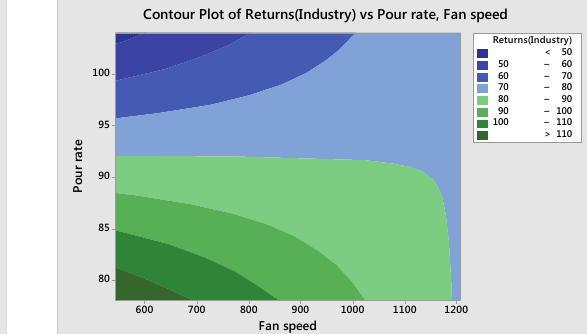
Contour Plot of Returns(Industry) vs Pour rate, Fan